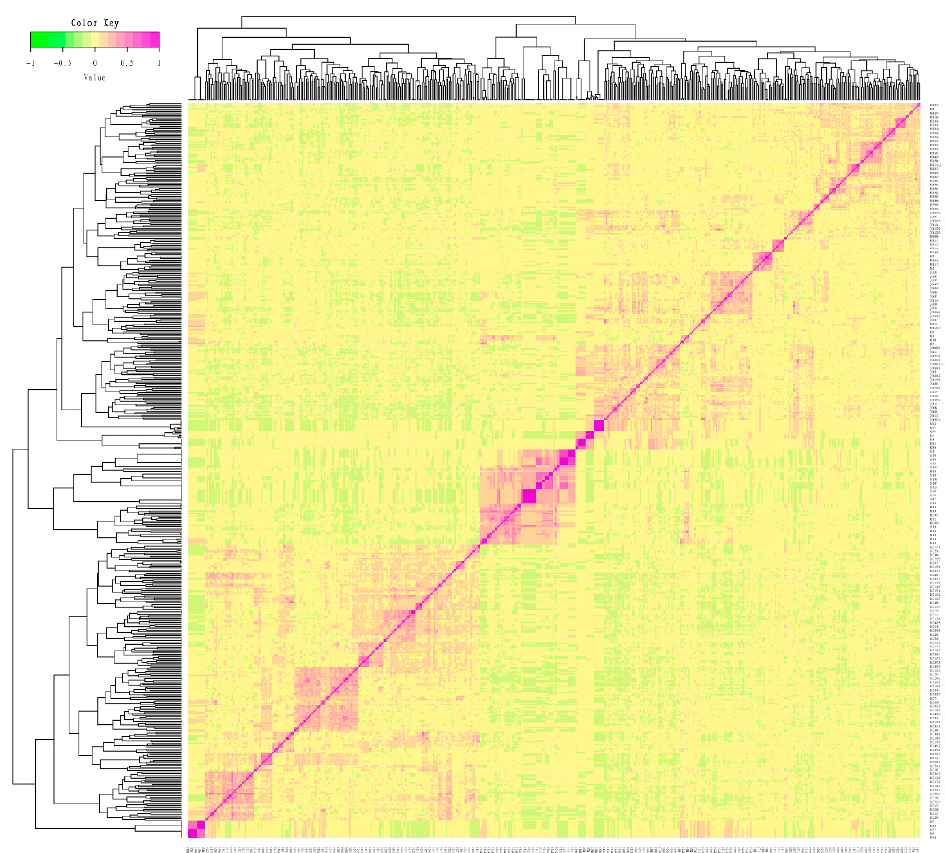
Figure 1. G matrix heat map of Licha black pigs in the conserved population. Each small square exhibits the kinship value between different individuals. The closer the color of squares is to red, the closer the kinship between individuals.